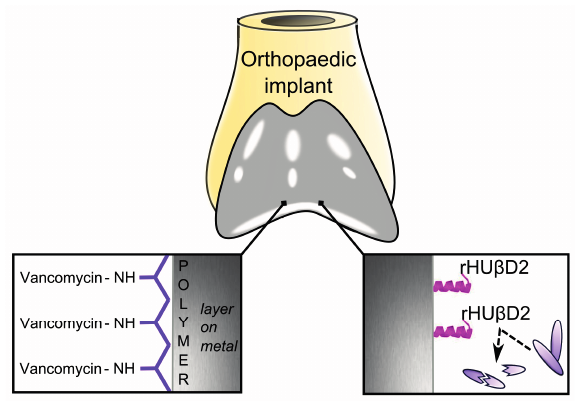
Figure 5. Two examples of antibacterial effect located on the surface of an implant. The first example demonstrates Vancomycin linkage to a carrier polymer; the second example shows tethered cationic antimicrobial peptides creating a contact killing surface utilizing recombinant human β -defensin-2 (rHU β